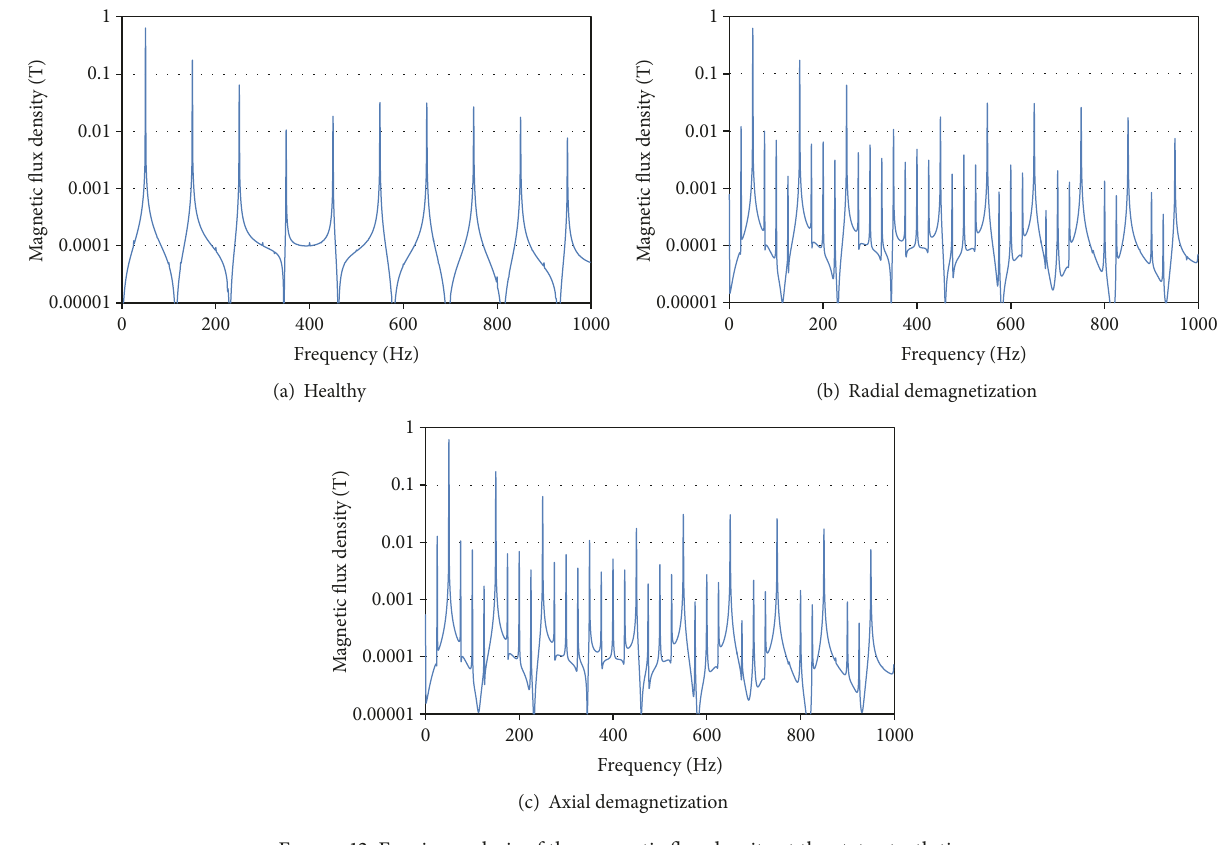
Figure 12: Fourier analysis of the magnetic flux density at the stator teeth tip.